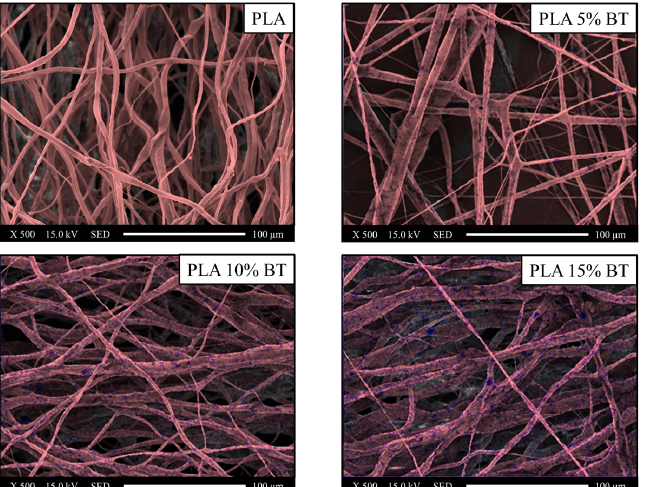
Figure 4. Images collected using EDX elemental maps of the PLA fibers and composites before aging tests and converted in two different colors (red for carbon and blue for barium) and overlaid on the SEM images in order to verify the incorporation of barium titanate inside the fibers and the distribution. EDX and SEM images were collected at 500 × magnification.